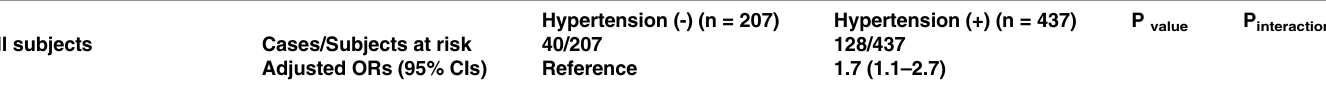
Strati fi ed analyses by tertiles of each